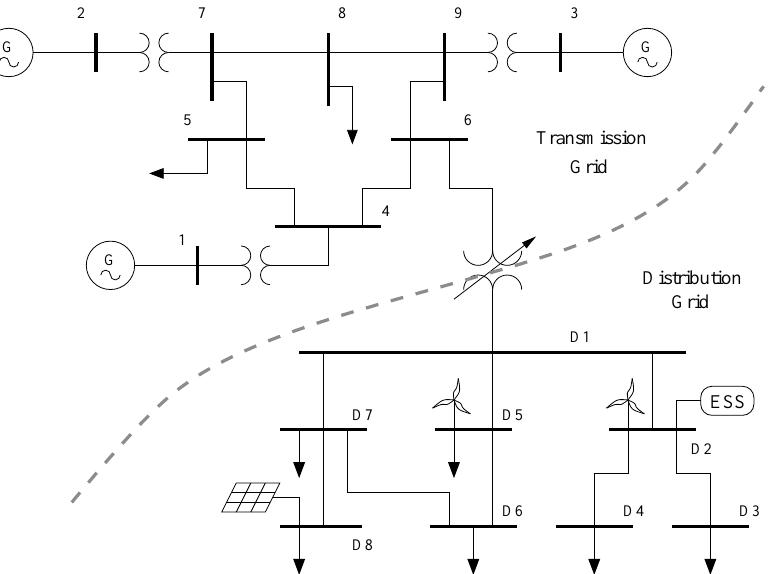
Figure 5. Modified WSCC 9-bus, 3-machine system with a